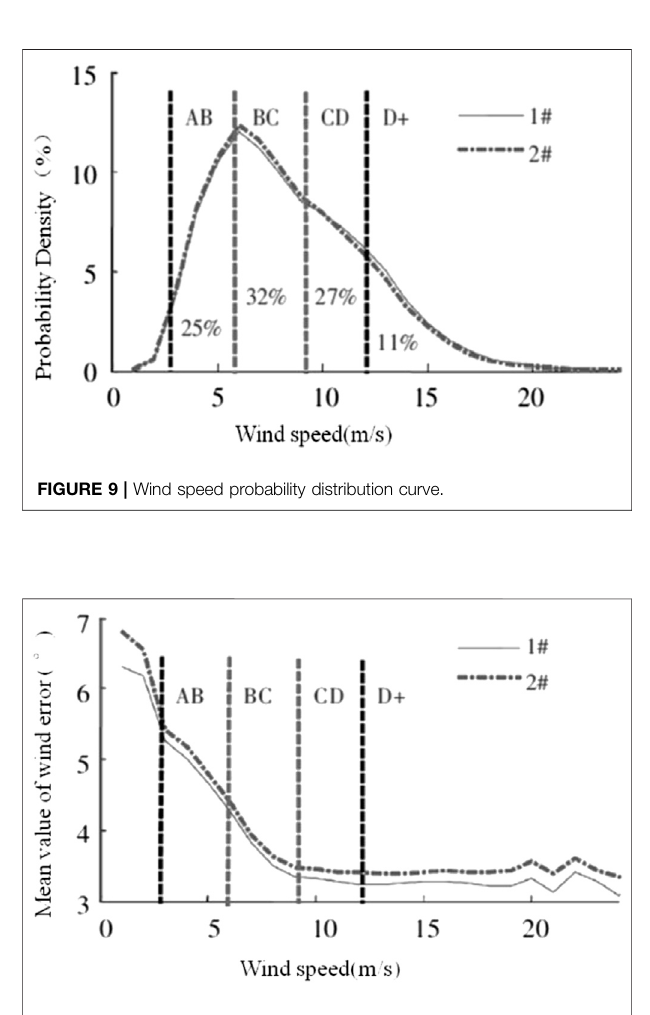
FIGURE 10 | The curve of the average wind error vs. wind speed.